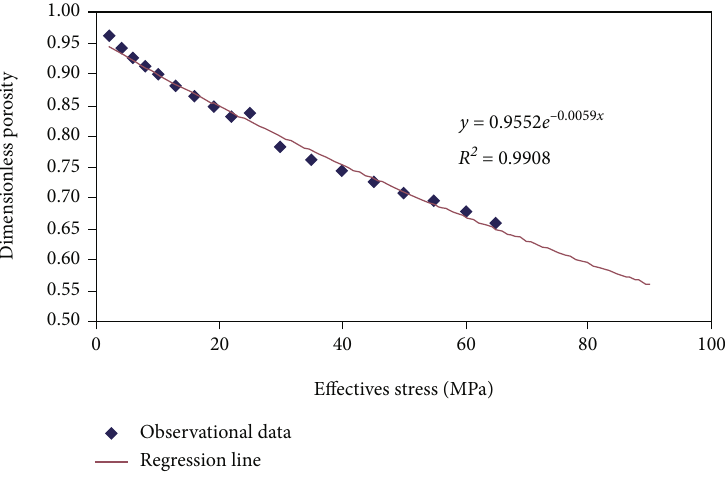
Figure 8: Relationship between dimensionless permeability and e ff ective